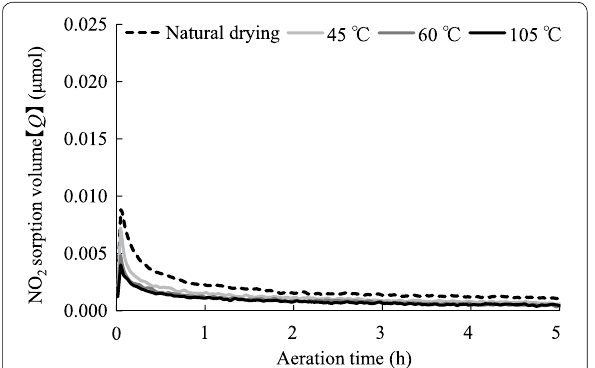
Fig. 5 NO 2 sorption volume per unit weight and time, Q w sor in non-extracted and extracted specimens under different drying conditions. The moisture content in the specimens was 0%. The error bars show the standard deviation ( n 3). *:0.05 > p (Tukey =